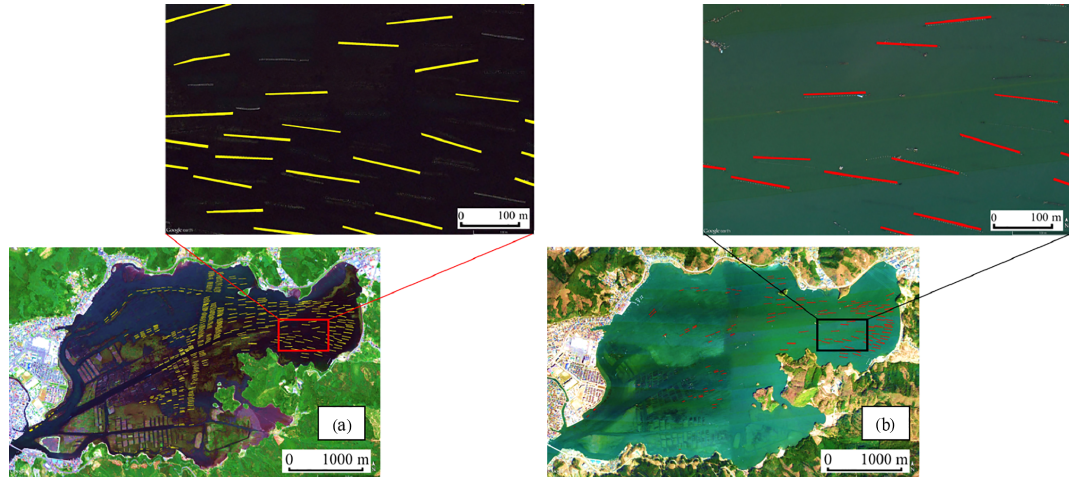
Figure 7. Visual damage interpretation of aquaculture rafts (long-line type) (a) before and (b) after the 2011 tsunami.